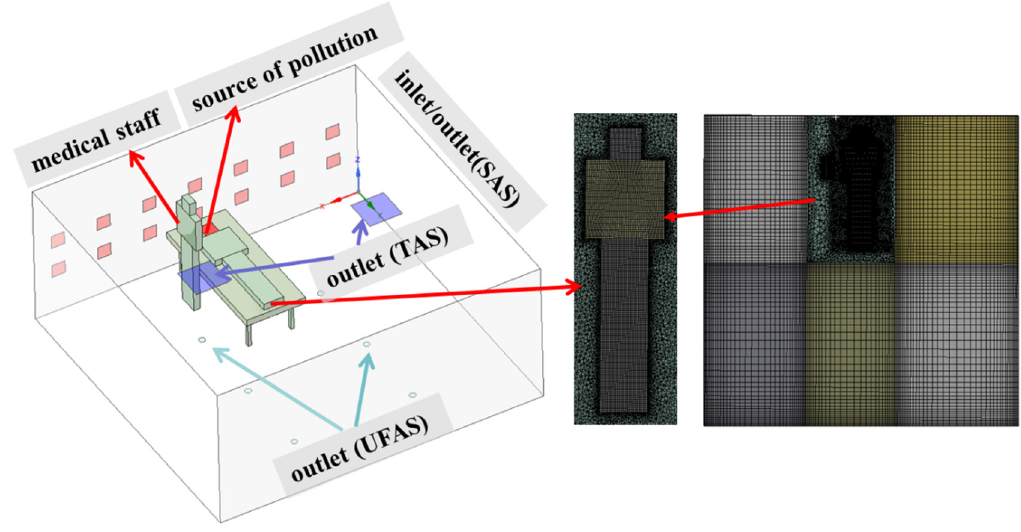
Figure 3. Schematic diagram of the CFD model and